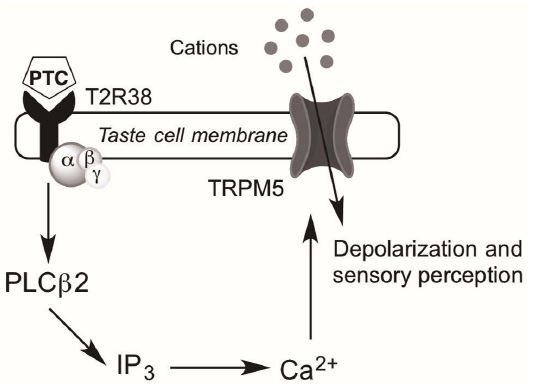
Figure 1. Intracellular taste receptor signaling. Binding of the bitter compound phenylthiocarbamide (PTC) to the T2R38 bitter taste receptor in sinonasal epithelial cells results in activation of an undetermined G-protein that then activates phosopholipase C isoform β 2 (PLC β 2), resulting in increased inositol 1,4,5-trisphosphate (IP 3 ) [16]. IP 3 induces the release of calcium (Ca 2+ ) from the endoplasmic reticulum. Ca 2+ -dependent activation of TRPM5 channels (transient receptor potential cation channel subfamily M member 5) depolarizes the membrane and results in bitterness perception